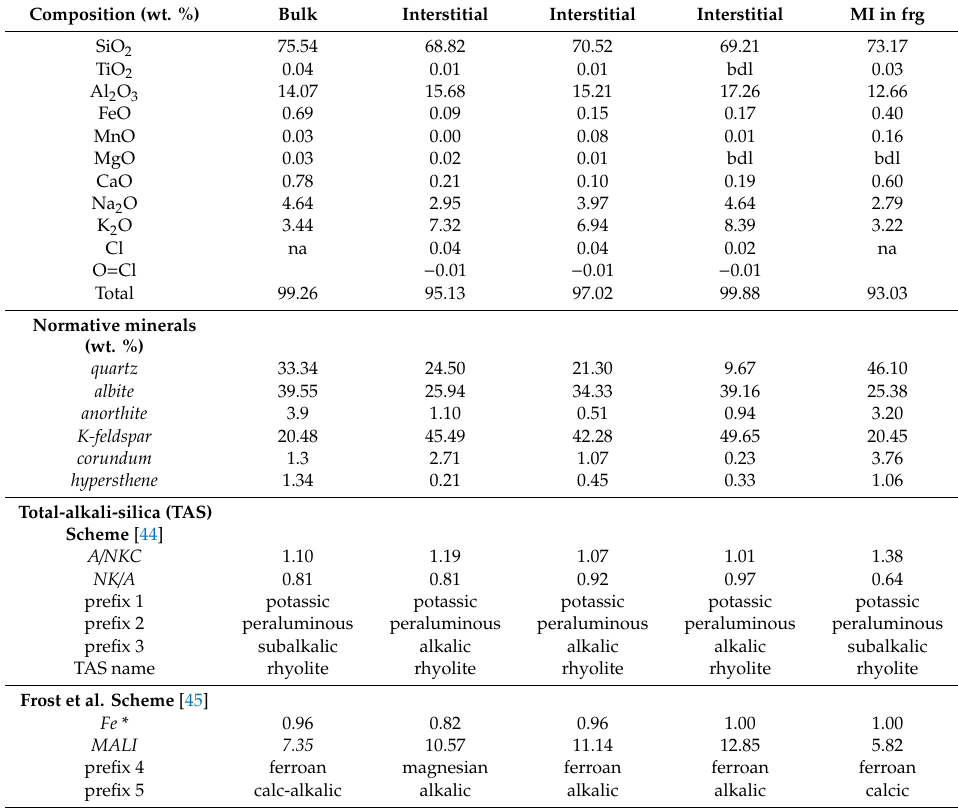
Table 1. Chemical compositions of interstitial glass, fergusonite-hosted glass inclusion (MI) and the xenolith host. Sample Ca3, data from